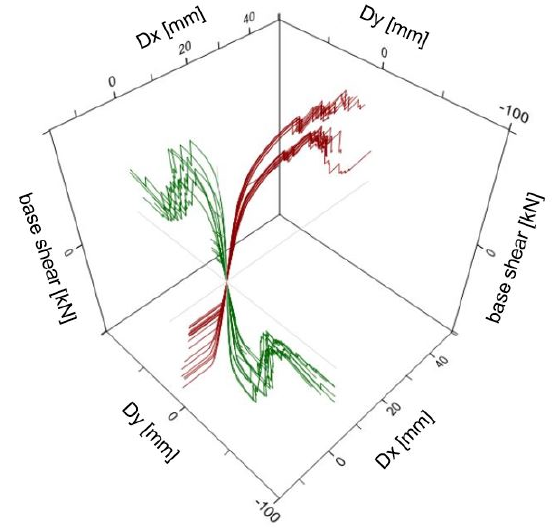
Figure 6. Capacity curves (current configuration).